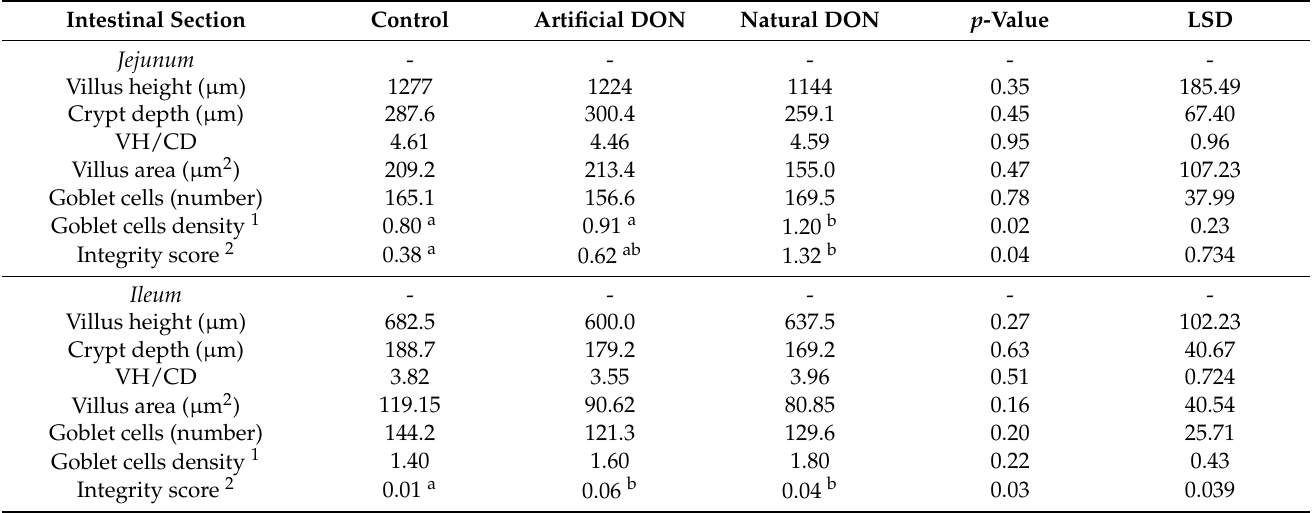
Table 5. Effect of experimental diets on morphometric and morphological parameters in jejunum and ileum from 28-days-old broiler